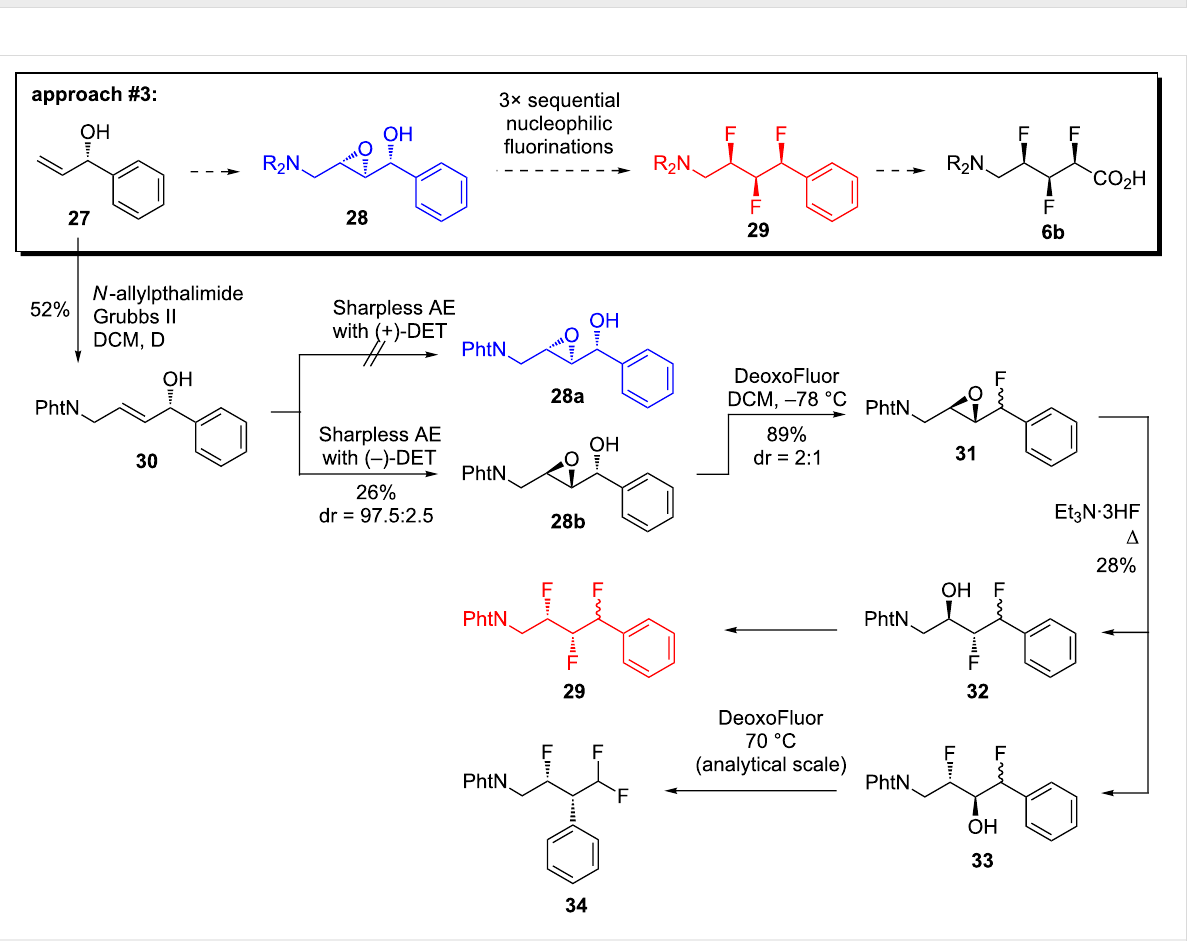
Scheme 3: The third synthetic